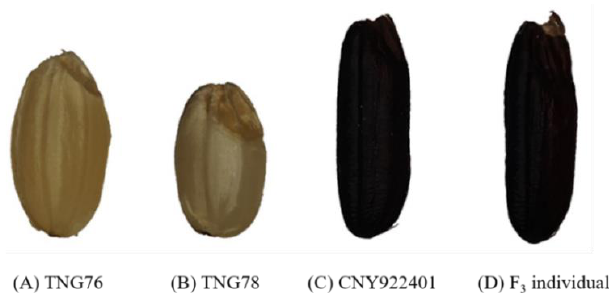
Figure 4. Frequency distribution of the recurrent parent genome (RPG) recovery rate estimated by markers in the F 2 generation of the purple functional rice population.